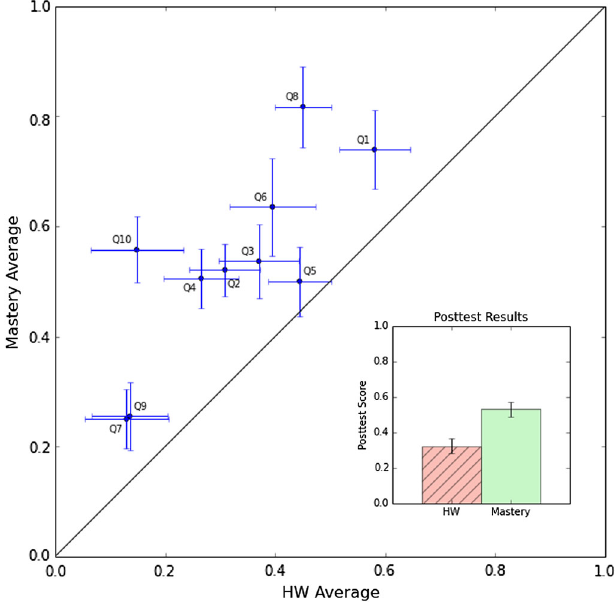
FIG. 4. Outset: Mastery group normalized average score HW group average for each question. Points above the line indicate the Mastery group outperformed the HW group. Inset: Normal- ized total post-test score average for both